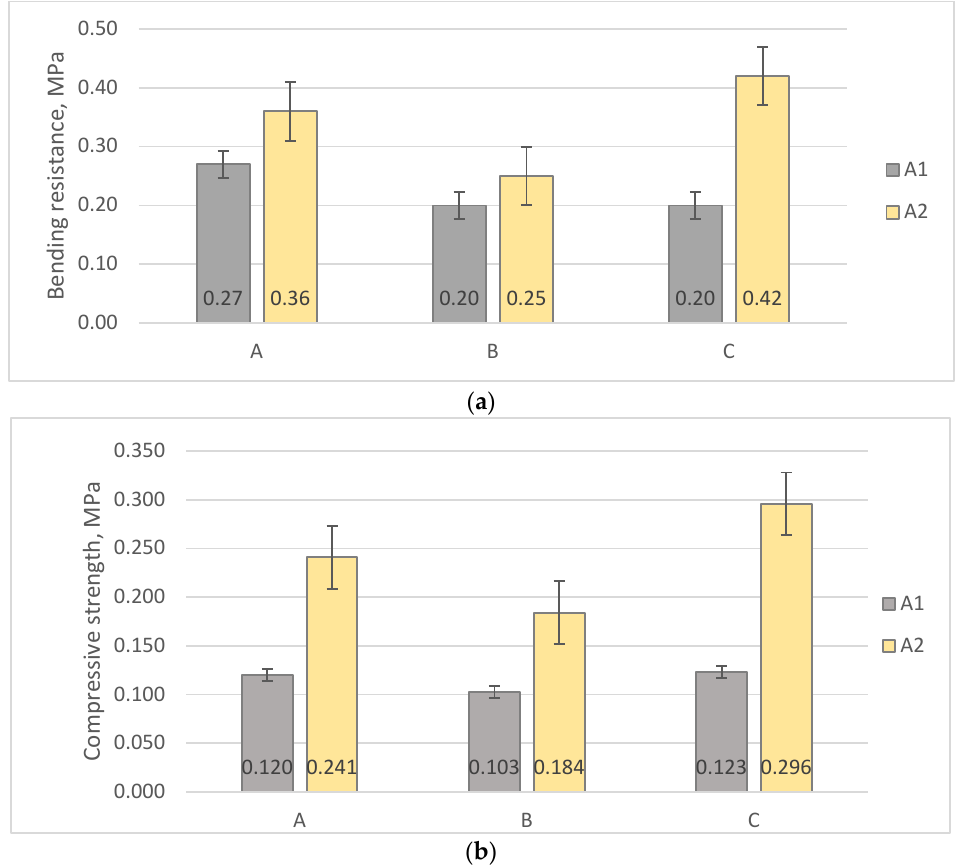
Figure 5. Mechanical properties of sapropel composite materials: ( a ) Bending resistance, MPa; ( b ) Compressive strength, MPa.